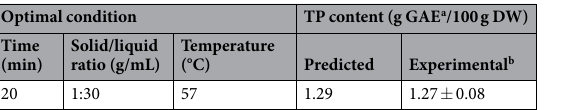
Table 2. Optimal condition and TP content obtained from prediction and real experiment under optimal condition. a Gallic acid equivalent. b Mean ± SD (n =